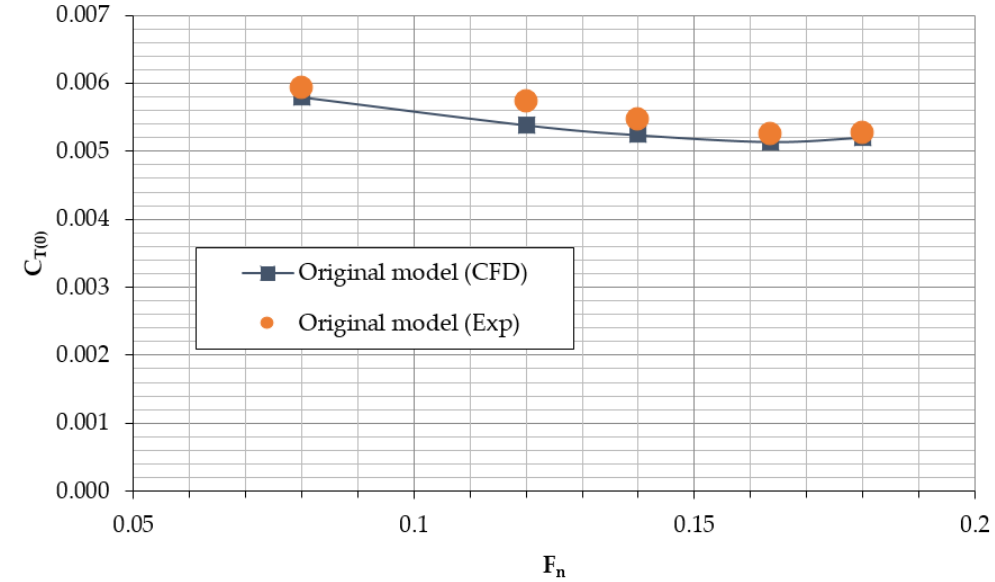
Figure 4. Comparison between the CFD results and experimental data of resistance acting on the ship in calm water.